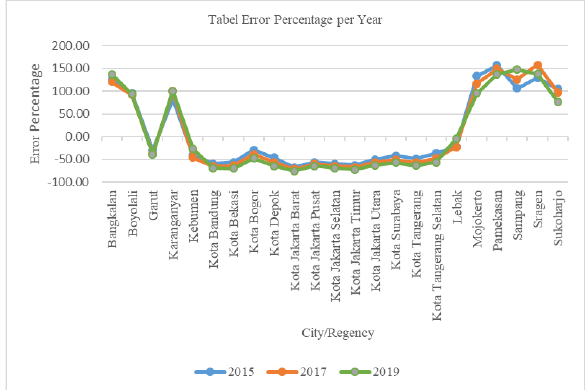
Figure 2. Graphic of percent errors of the population estimation models per year by